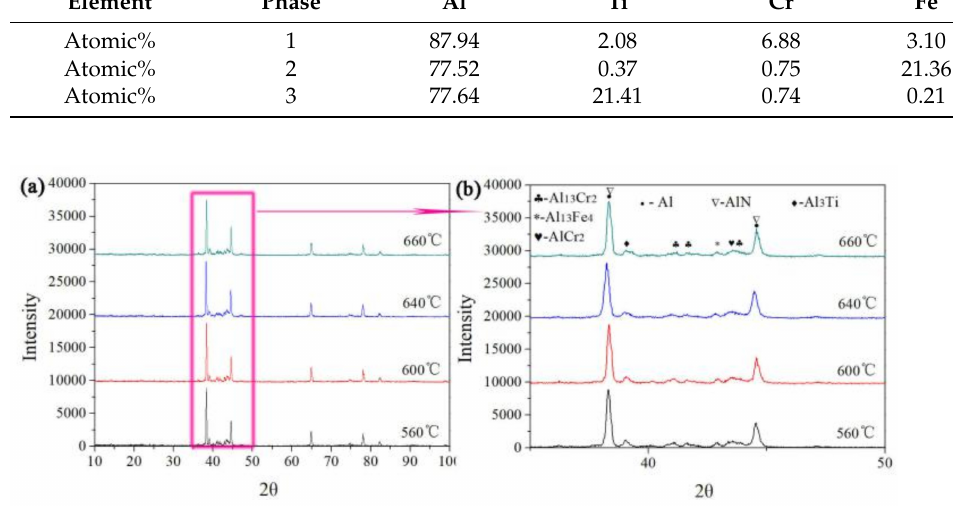
Figure 7. XRD of the sintered samples with different sintering temperature: ( a ) full scan from 10 to 100 ◦ ( b ) enlargement of the 30 to 50 ◦ section.